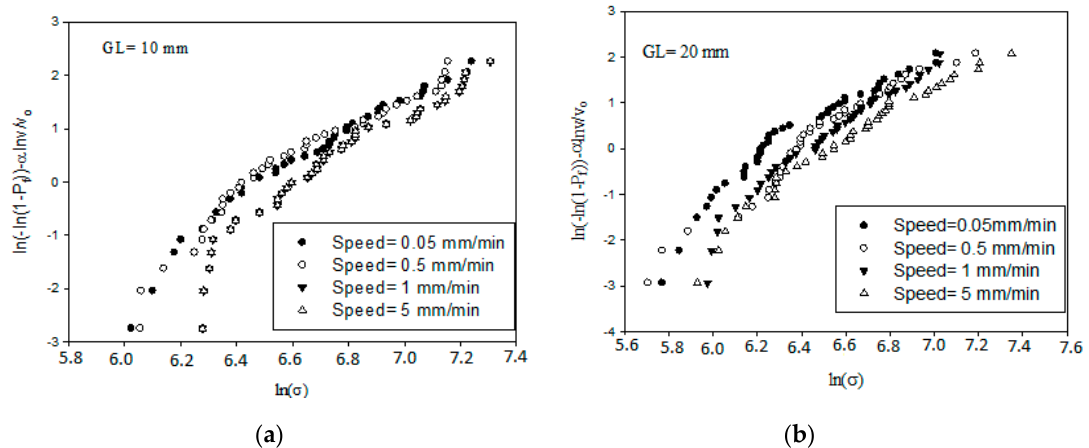
Figure 5. Weibull fit of the strength ( a ) at gage length 10 mm and ( b ) at gage length 20 mm.